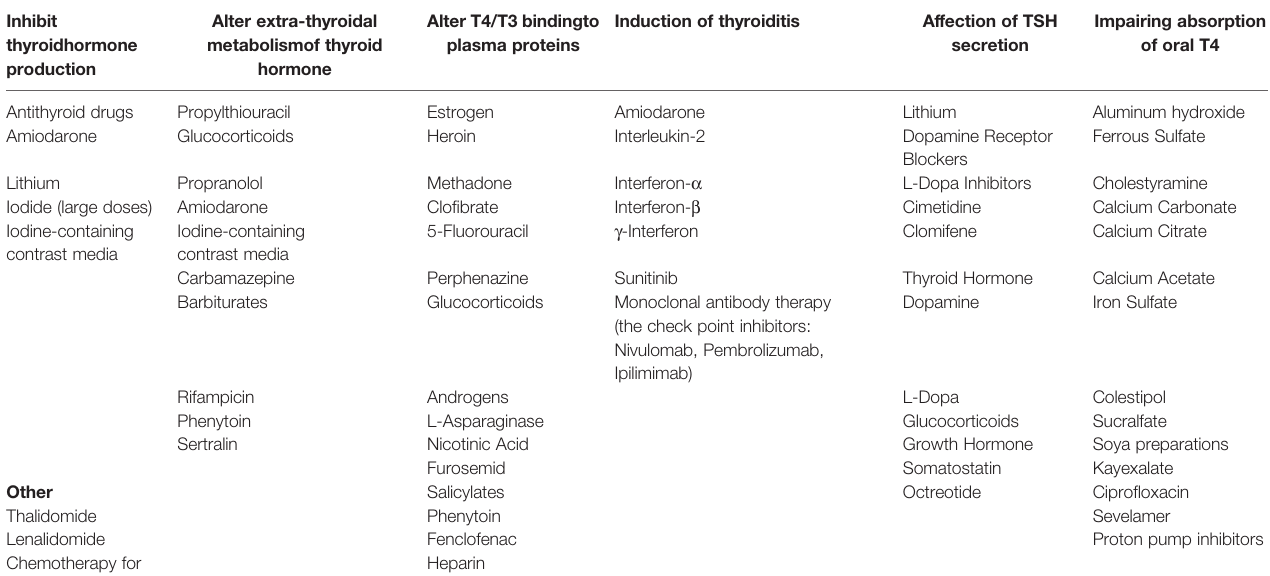
TABLE 1 | Drugs with an increased likelihood of inducing thyroid